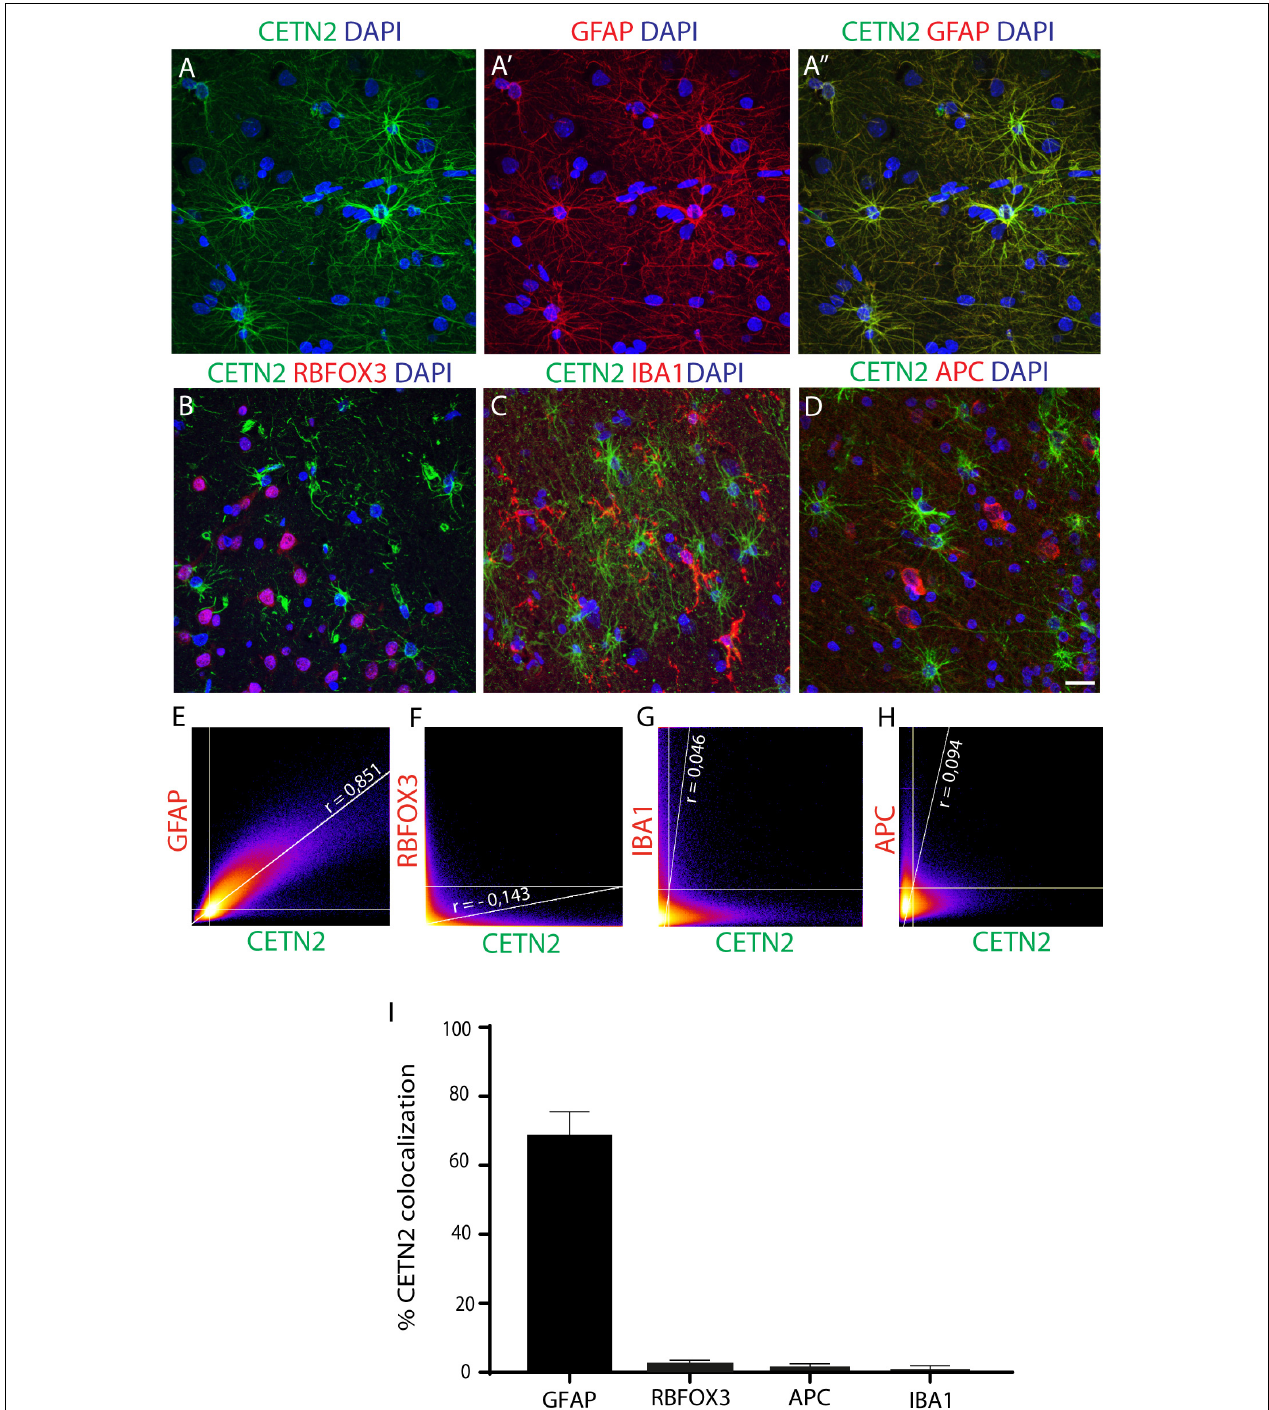
FIGURE 2 | CETN2 specifically labels astrocytes. (A–A”) CETN2 labeling overlaps with canonical astrocytic marker GFAP in human prefrontal cortex sections. (B–D) CETN2 specificity is confirmed by a lack of co-localization with neuronal protein RNA-binding fox-1 homolog 3 (RBFOX3), microglial marker ionized calcium-binding adaptor molecule 1 (IBA1), and mature oligodendrocyte marker adenomatous polyposis coli (APC). (E–H) Scatterplot correlation graphs showing robust co-localization of CETN2 with GFAP and poor overlap with RBFOX3, as well as with IBA1 and APC. Pearson’s coefficients are indicated on each plot. (I) Histogram shows CETN2 co-localization percentages with other neuronal and non-neuronal cell types. Data represent mean ± SEM. Scale bar: (A–D) 20 µ m.